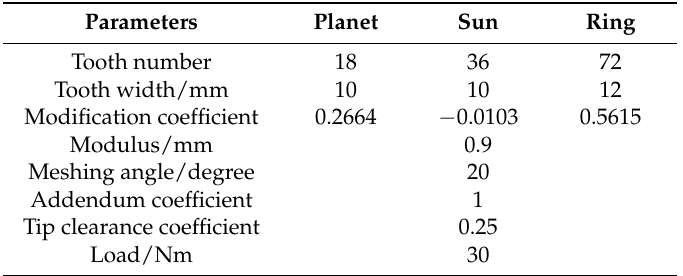
Table 1. Parameters of the planetary gearbox.